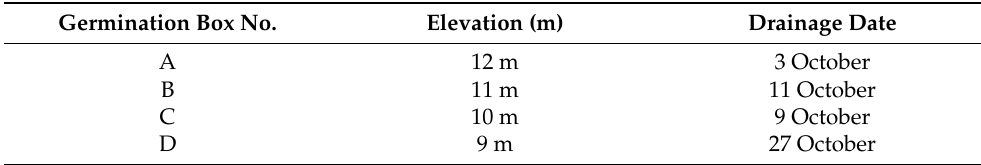
Table 1. Treatments of the experimental design. Germination Box